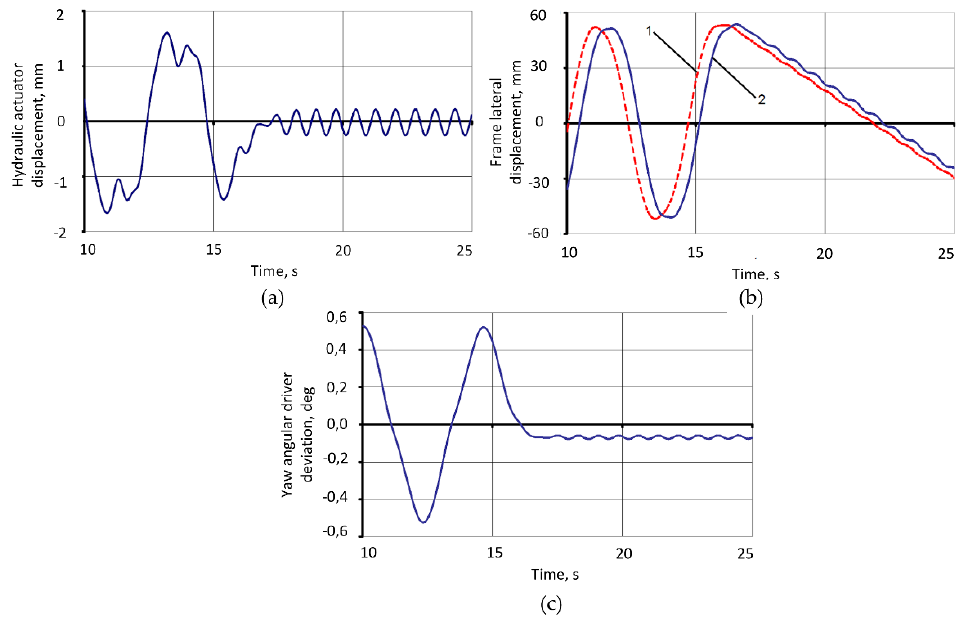
Figure 13. Example of simulation for inert driver model, siting at the front of the vehicle—( a ) hydraulic actuator displacement, ( b ) lateral displacement of front (1) and rear (2) axle, and ( c ) yaw angular driver deviation.